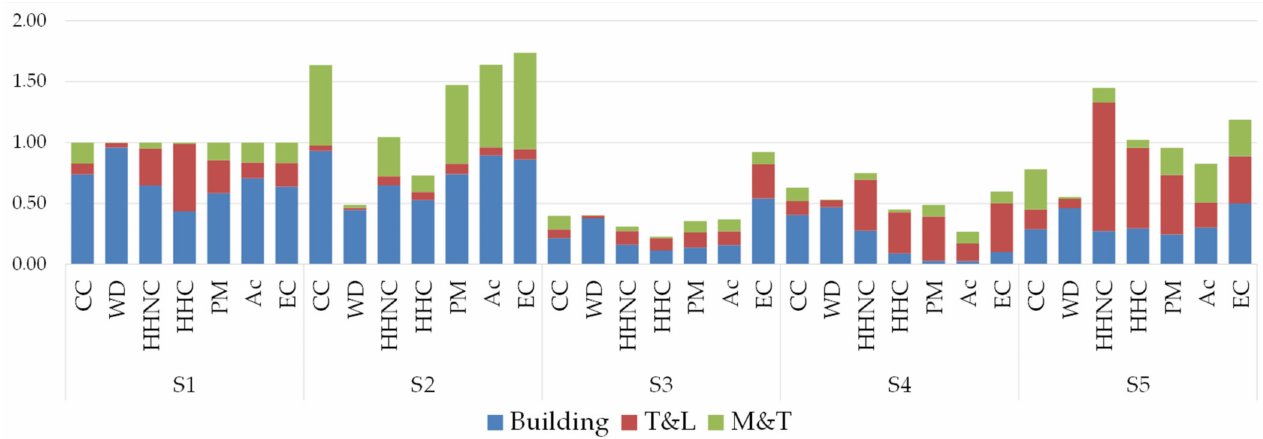
Figure 2. Contribution of subsystems—buildings, training, and learning (T&L), and mobility and transport (M&T) of the sample of schools (S1, S2, S3, S4m and S5) to the results of the assessment of environmental impacts and external costs. CC: climate change; WD: water depletion; HH: human health (HHNC: non-cancer effects and HHC: cancer effects); PM: particulate matter; AC: acidification; EC: external costs. The vertical axis represents the impact result of each school and impact category normalized by the results of School 1 (S1), establishing the proportional size related to this school (S1 =